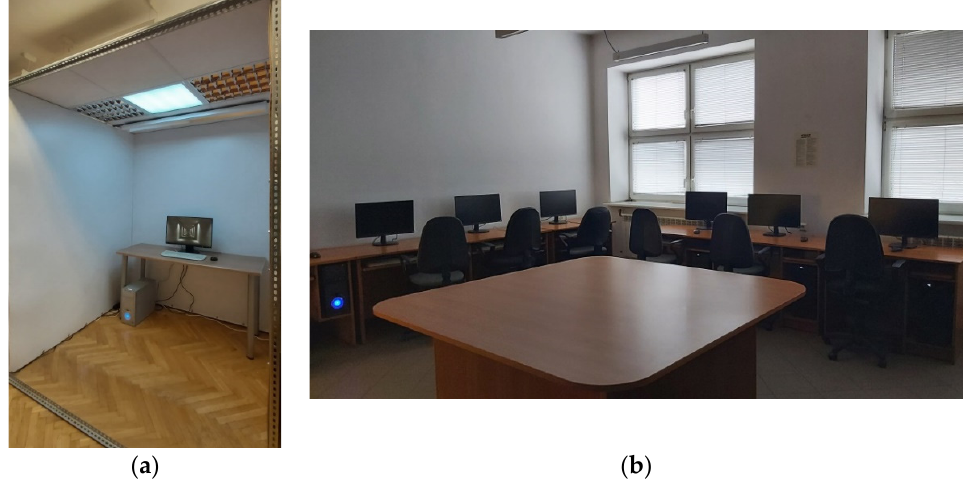
Figure 3. Experimental conditions for group: B (Box) ( a ) and C (Classroom) ( b ).